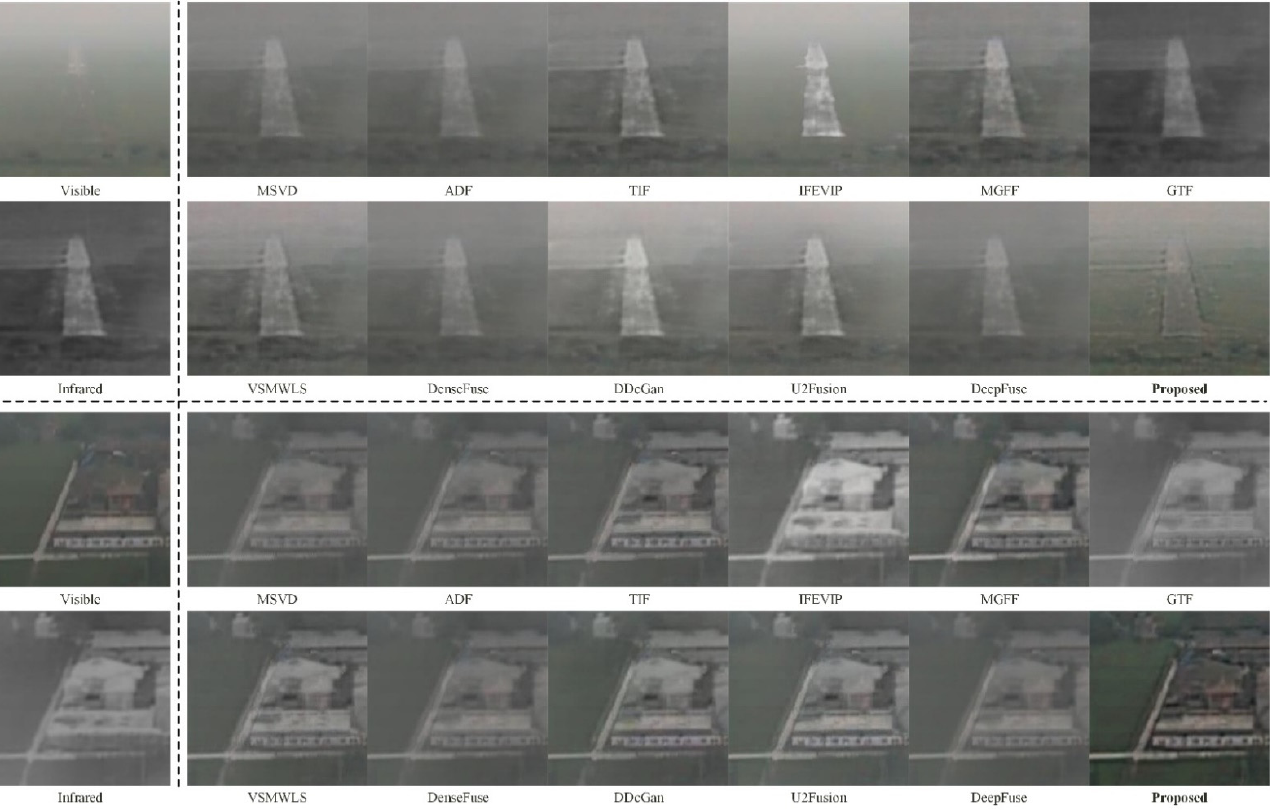
Figure 8. Comparison of fusion details.